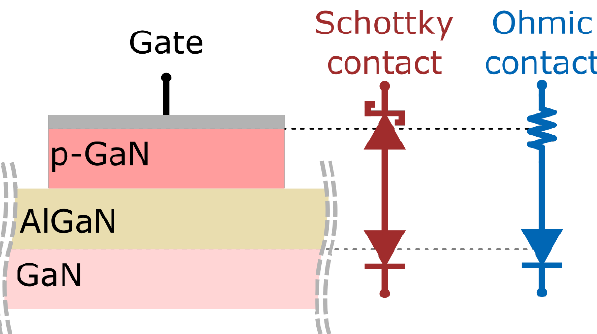
Figure 3. Ideal representation of the cross-section of the region forming the gate heterostructure in a p-GaN gate HEMT. The equivalent circuits corresponding to the Schottky and Ohmic gate contact types are also reported.